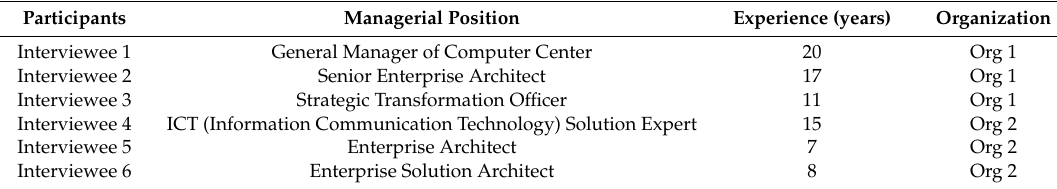
Table 3. Phase 2 participants.